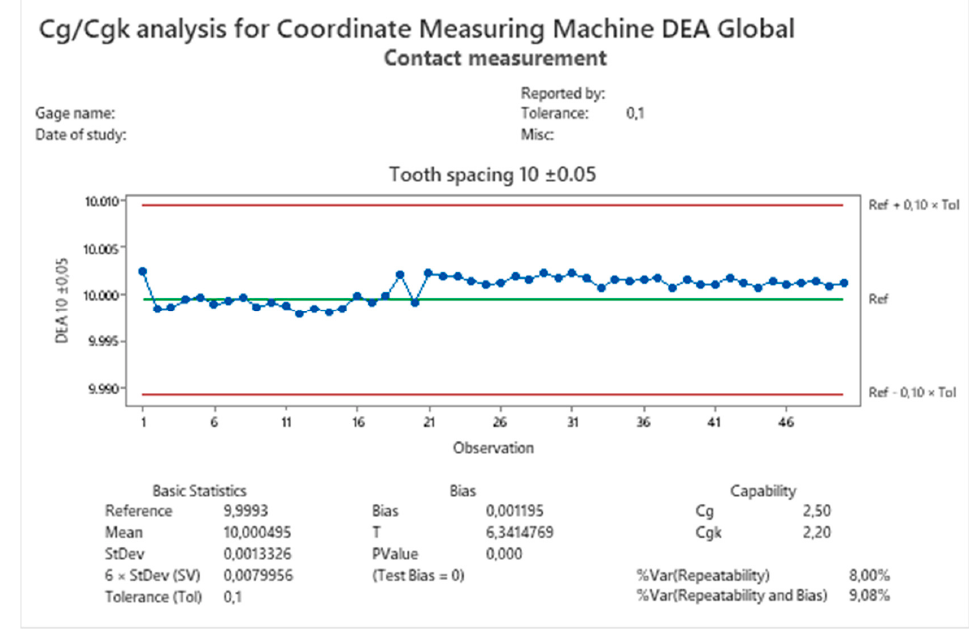
Figure 18. Tooth spacing 10 ± 0.05 mm—Cg/Cgk indicators for the LH-600 height gauge (own